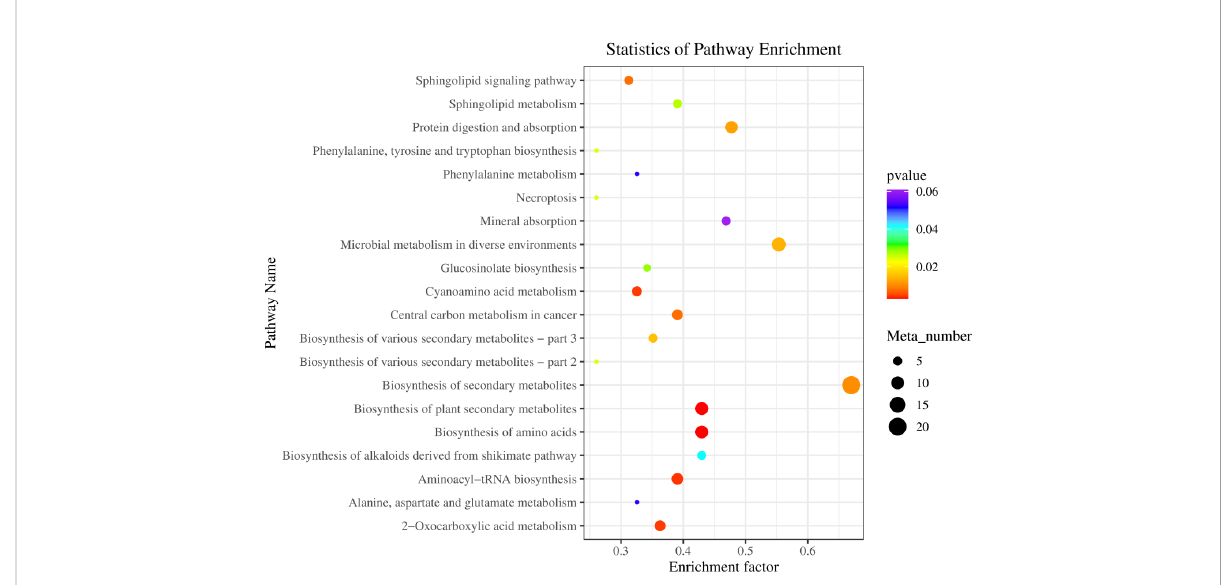
FIGURE 7 KEGG pathway enrichment of differential metabolites in fecal between LF and BC groups. Colors indicate enriched Q-value; the redder color represents a smaller Q-value. The size of the bubble indicates the number of metabolites mapped within a KEGG pathway. KEGG, Kyoto Encyclopedia of Genes and